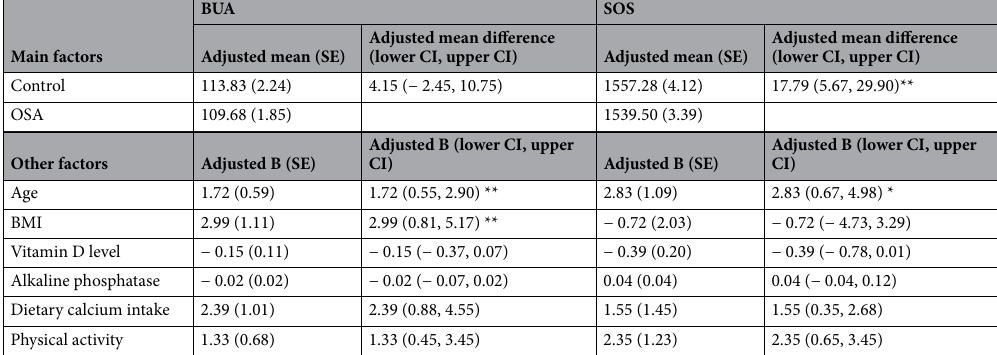
Table 5 showed the multiple variables multivariate covariance analysis on BUA and SoS. Overall, the combined dependent variables of BUA and SOS were different among participants with OSAS compared with those in control group (Wilk’s Lambda = 0.940; F(2,143) = 4.526; p = 0.012) after adjusted by other factors like age, BMI, vitamin D level and alkaline phosphatase level. Note that the main effect of OSA on BUA was not significant [F(1,144) = 1.547; p = 0.216] but was significantly associated with SoS [F(1,144) = 8.424; p = 0.004] after controlled by the other variables. The total variances explained by the model corresponding to BUA and SOS were adjusted R 2 = 10.7% and adjusted R 2 = 15.3%, respectively.